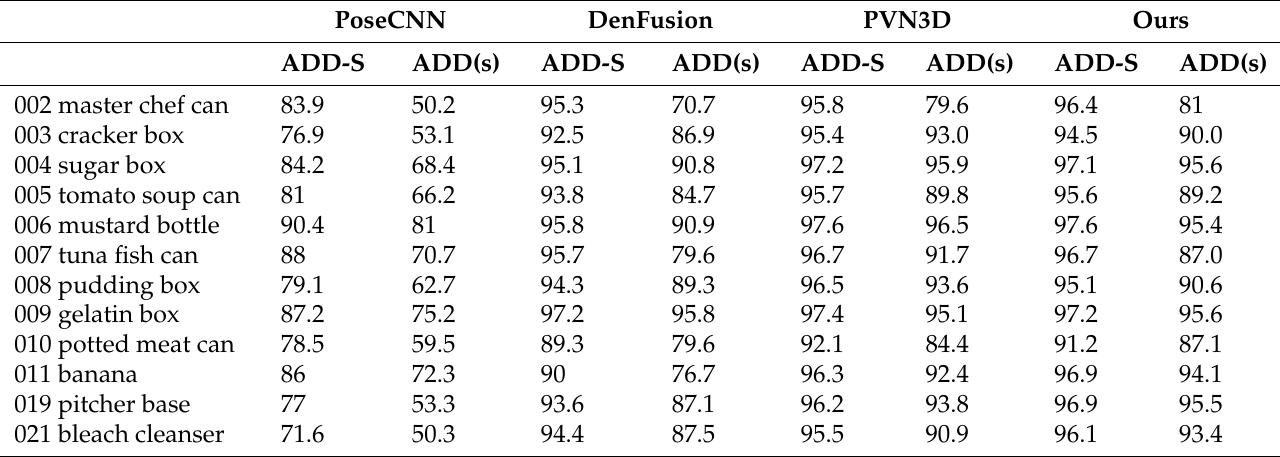
Table 2. Quantitative evaluation of 6D Pose (ADD-S, ADD(S)) on the YCB dataset. Symmetric objects’ names are in